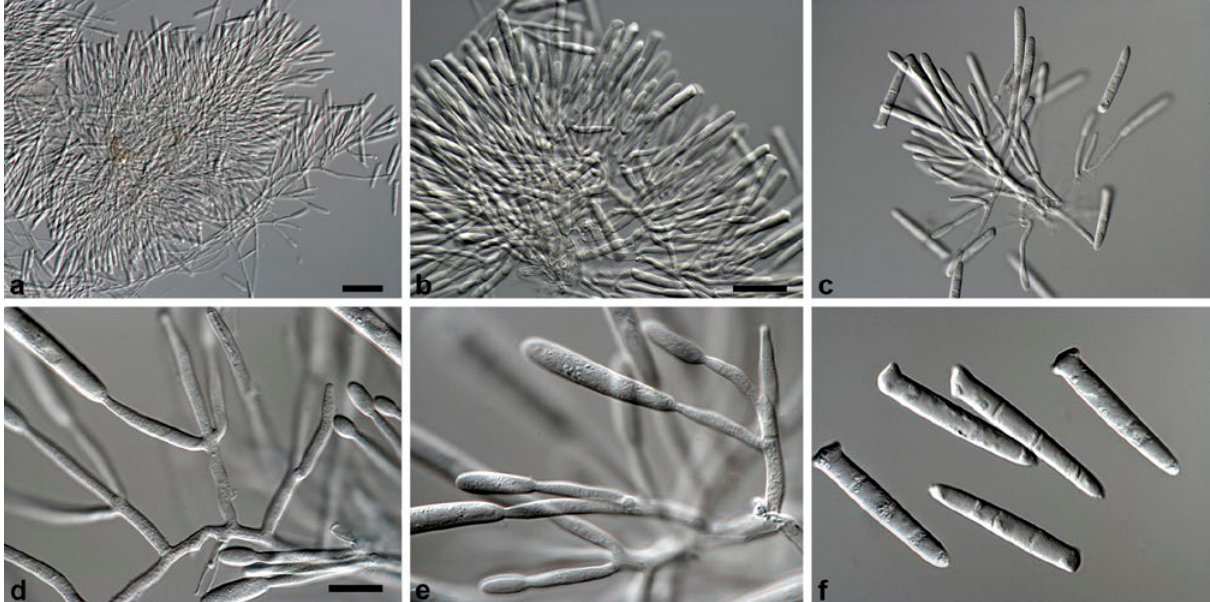
Figure 4. Neonectria lugdunensis (ex-type CBS 250.58). a–e. Complex conidiophores. f. Macroconidia. Scale bars: a = 50 μ m, b = 20 μ m (apply to c), d = 10 μ m (apply to